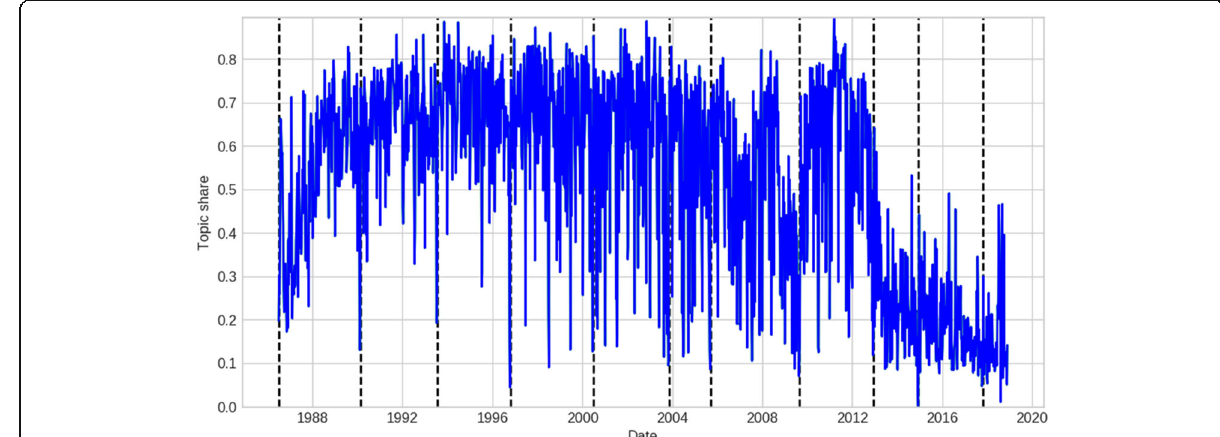
Fig. 12 Topic share of economic policy topic